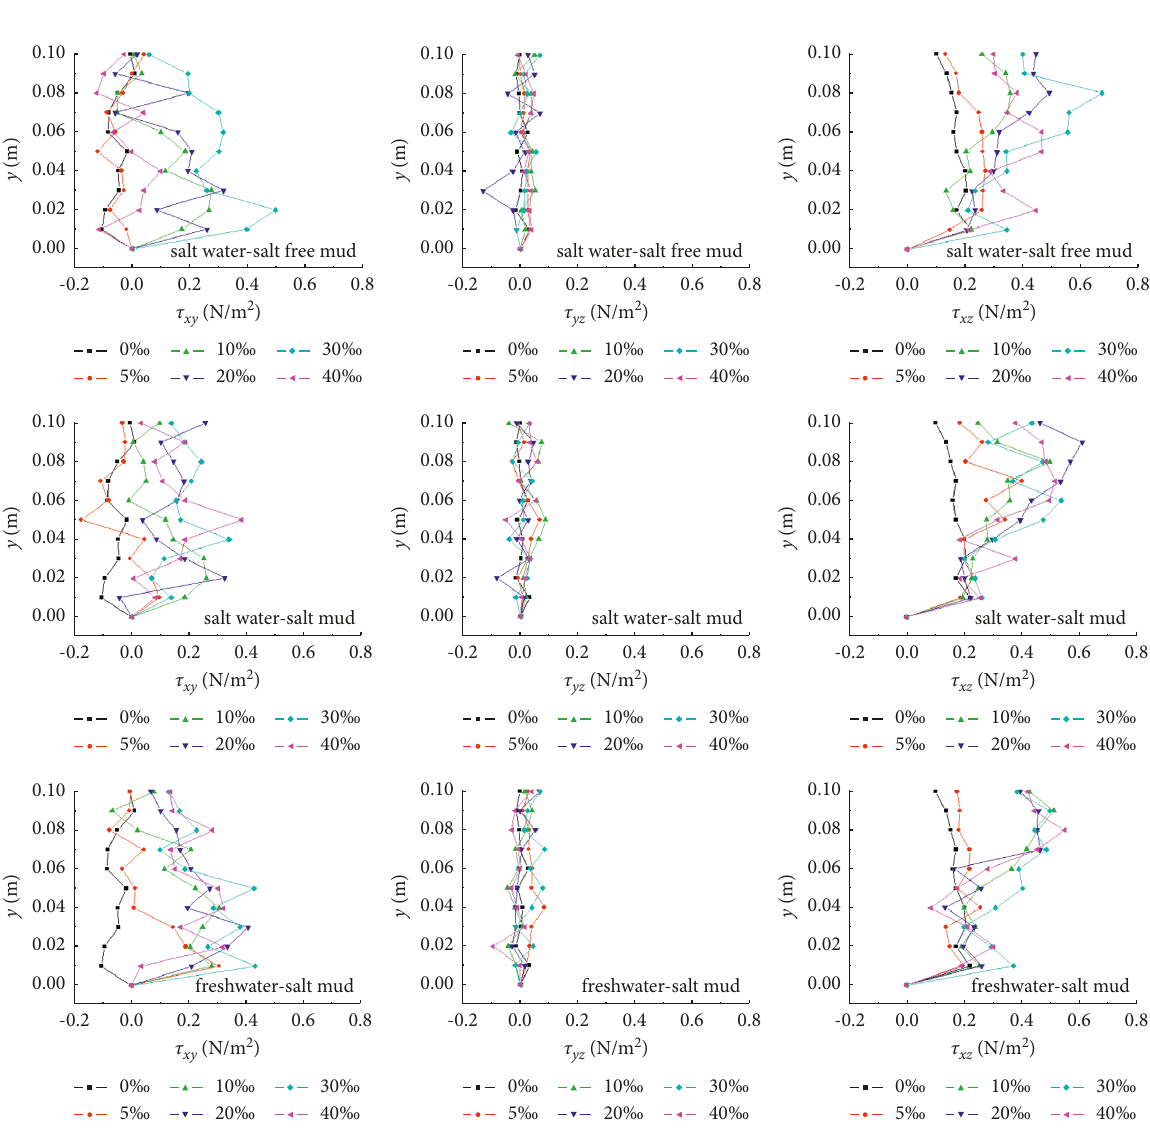
Figure 6: Turbulent stress of flow during the muddy clay